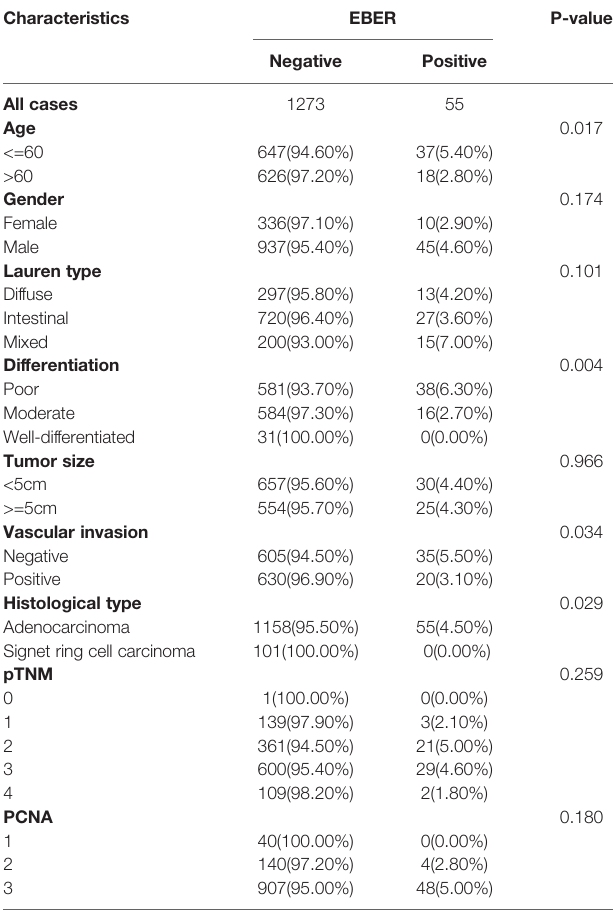
TABLE 1 | Clinical and molecular characteristics of patients according to EBER.